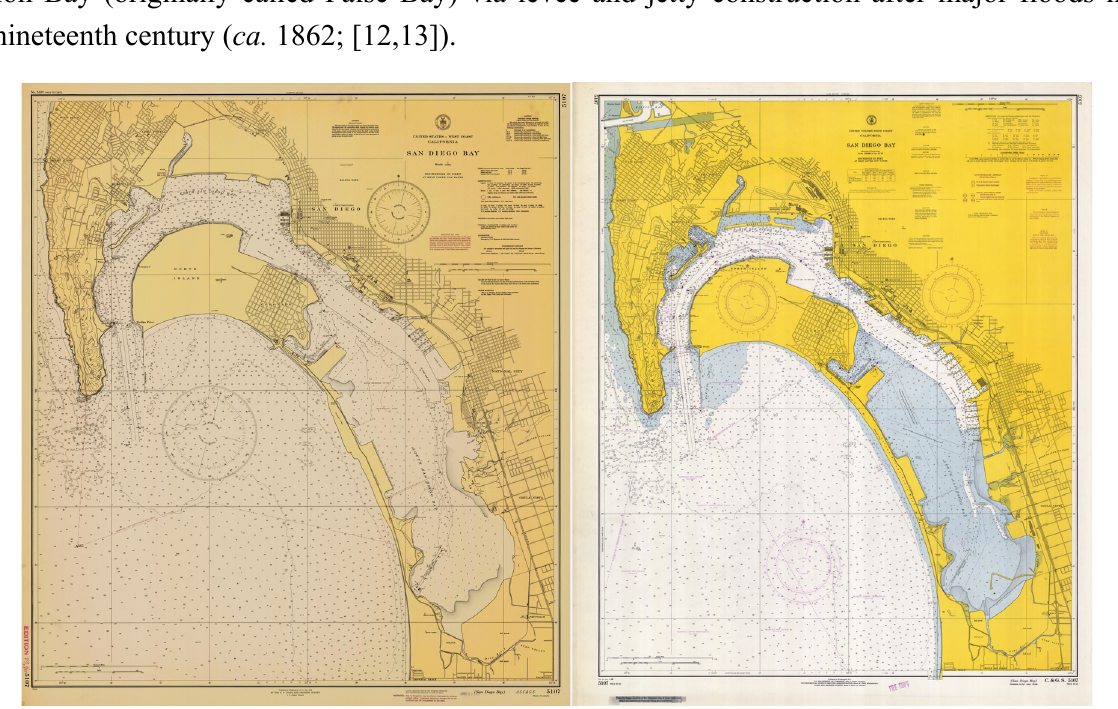
Figure 2. ( Left ) Nautical chart of San Diego Bay of 1945; ( Right ) Nautical chart